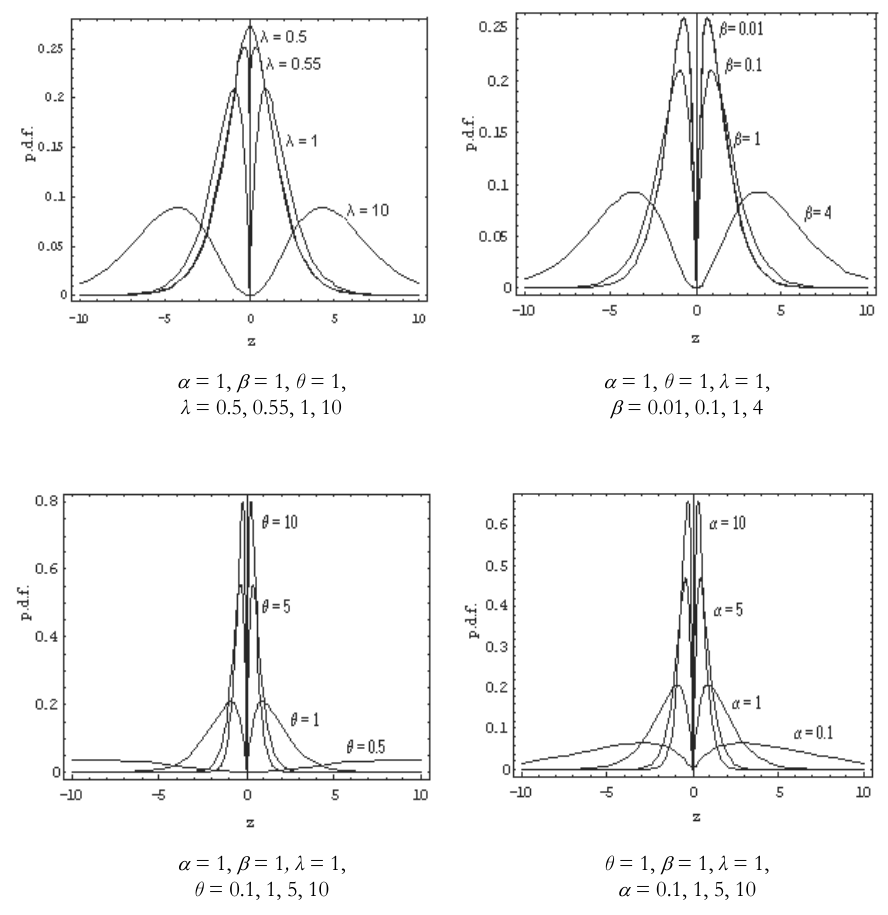
Fig. 3 – Different possible shapes of the p.d.f. (58) for specified values of parameters λ ,  , θ and 